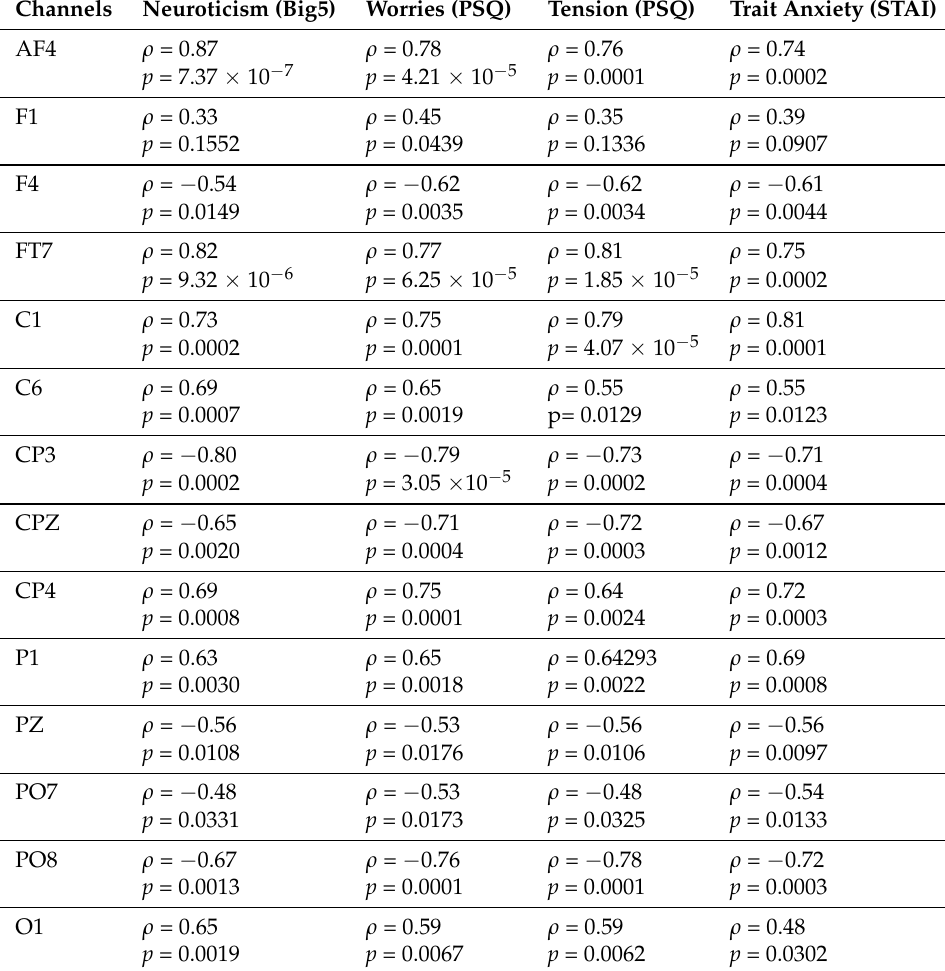
Table A13. Eyes-Open (EO) setting. Paired Spearman correlations between participants’ cumulative TEs and their responses to questionnaires. The cumulative TEs are associated with the EEG channels whose cumulative TEs were significantly different between HIGH and LOW stress-susceptible groups. These channels were AF4, FP2, F1, F6, CP3, CP4, P2, P3, and O2. The questionnaires were neuroticism (Big5), worries (PSQ), tension (PSQ), and trait anxiety (STAI). In this figure, the row entries associated with each of these EEG channels are marked along the figure’s vertical axis. The questionnaires are marked column-wise and along the horizontal axis and at the top of subplots’ columns. In each subplot, the cumulative TEs are along the x-axis and questionnaires’ responses are along the y-axis. The ρ and p represent the Spearman correlation coefficient and its corresponding p -value. Neuroticism (Big5) Worries (PSQ) Tension (PSQ) Trait Anxiety